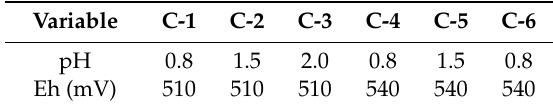
Table 1. Conditions and nomenclature in column leaching